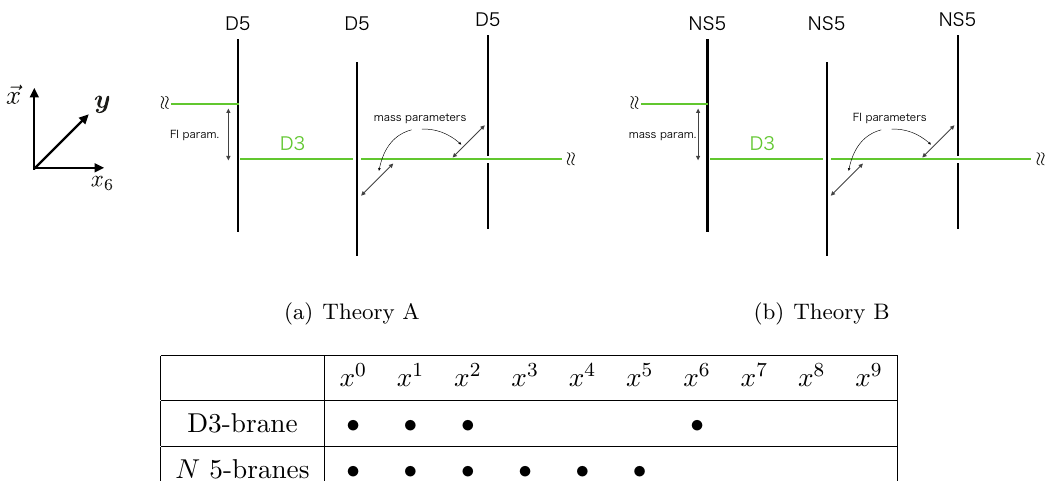
Figure 8 . Brane con(cid:12)gurations for the dual pair with N = 3. The x 6 direction is compacti(cid:12)ed